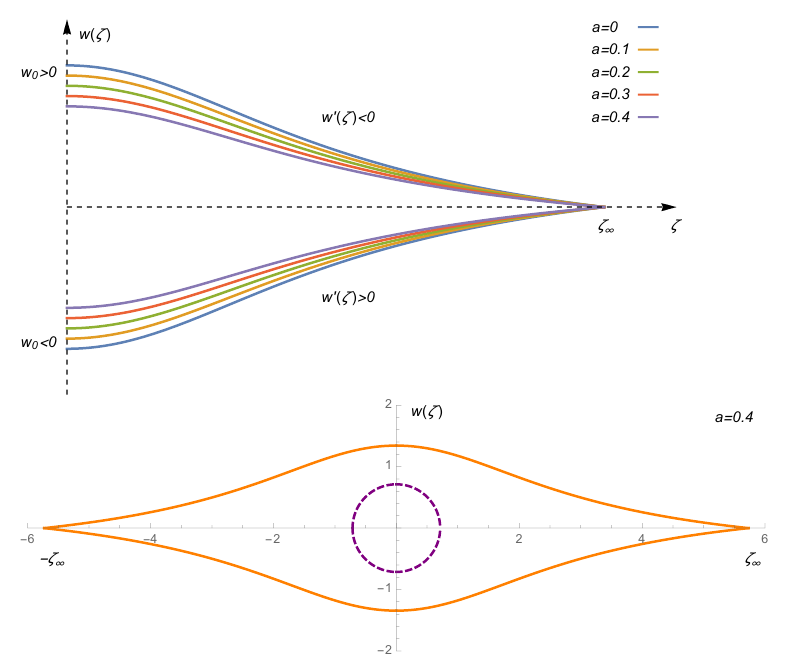
Figure 8 . The two parity-related minimal embeddings of the flavor branes in the massless case with various a . The parameter is chosen as L 2 /u KK = 1 , ζ ∞ = 5 . 73 . Upper: the dependence on a of the flavor embeddings. Lower: the full configuration of the parity-related flavor branes with a fixed a . The purple dashed line represents the position u = u KK .